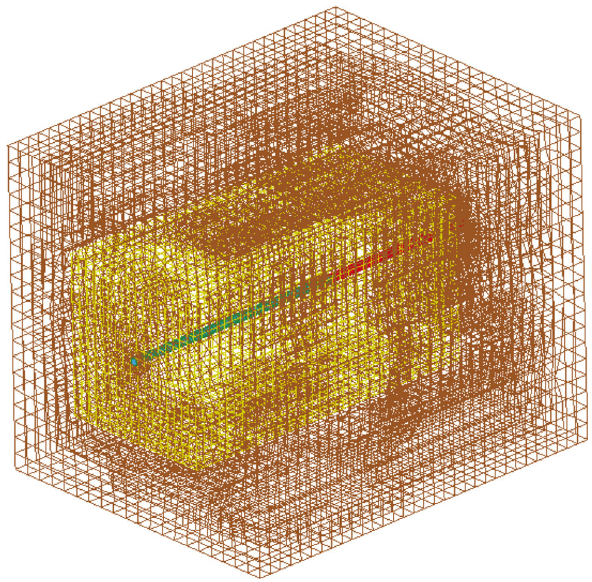
Fig. 4 Established numerical calculation